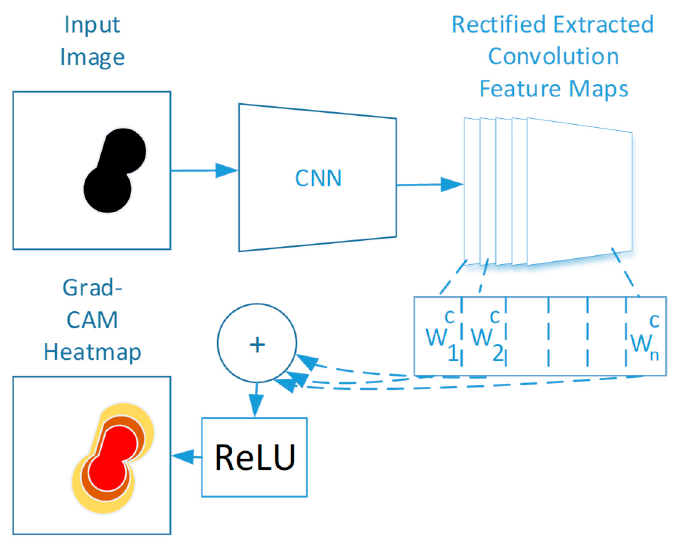
Figure 2. Flowchart and components of Grad-CAM.